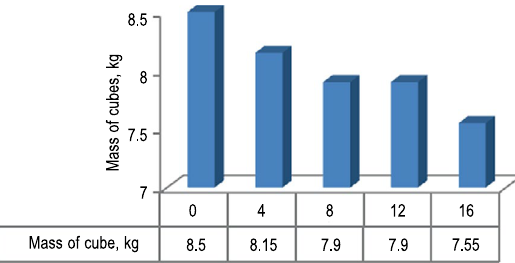
Fig. 5. Mass of concrete cubes at 28